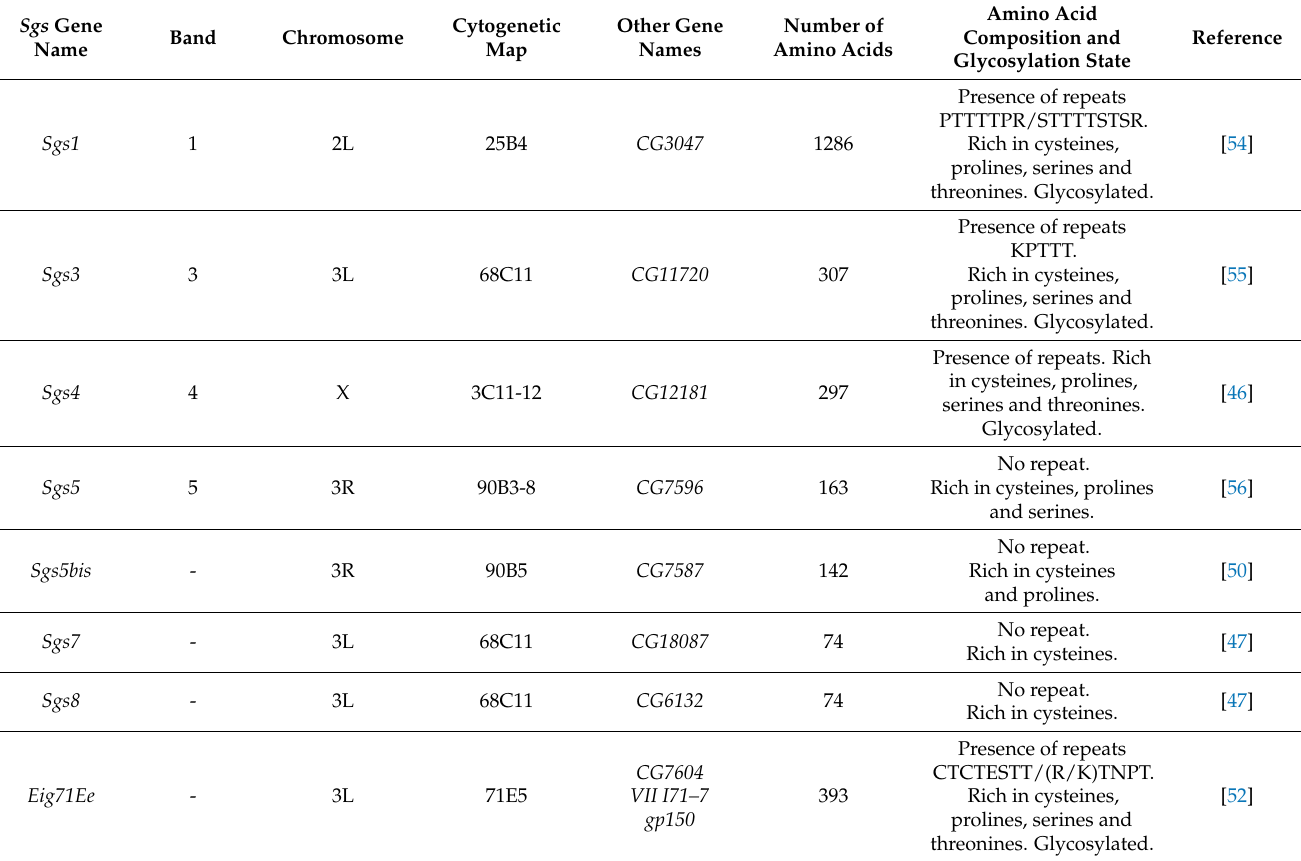
Table 1. List of the main glue genes of D. melanogaster and their characteristics. See FlyBase (http: //flybase.org, accessed on 8 July 2022) for further